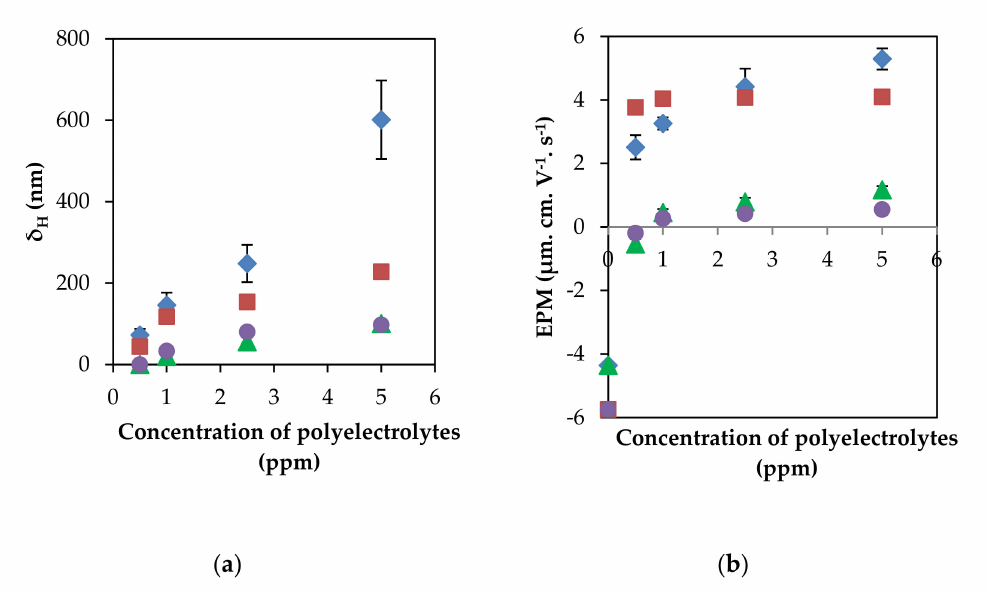
Figure 2. Variation of: ( a ) the hydrodynamic-adsorbed layer thickness, δ H and ( b ) the electrophoretic mobility of polyelectrolyte-adsorbed PSL particles, EPM acting as a function of the polyelectrolyte dosage after 5 min of incubation at different salt concentrations, including 0.1 mM KCl: PTMA5M ( (cid:7) ), PTMC5M ( (cid:78) ) and 10 mM KCl: PTMA5M ( (cid:4) ), PTMC5M ( • ). The error bars denoted the standard deviations of at least three different